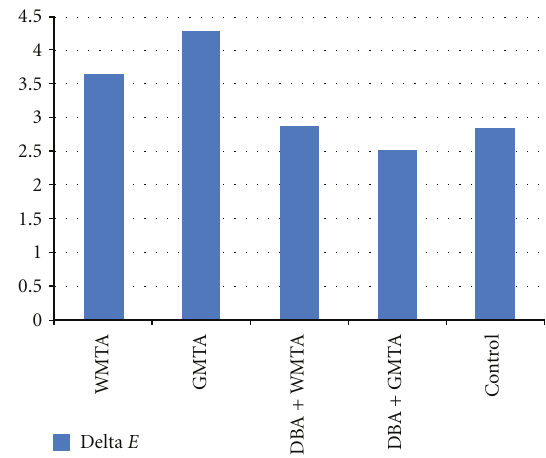
Figure 1: Mean tooth discoloration in 5 groups after 6